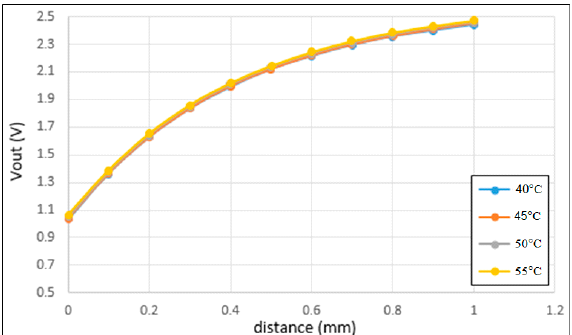
Figure 13. Correlation between output voltage and sensing distance following temperature compensation.